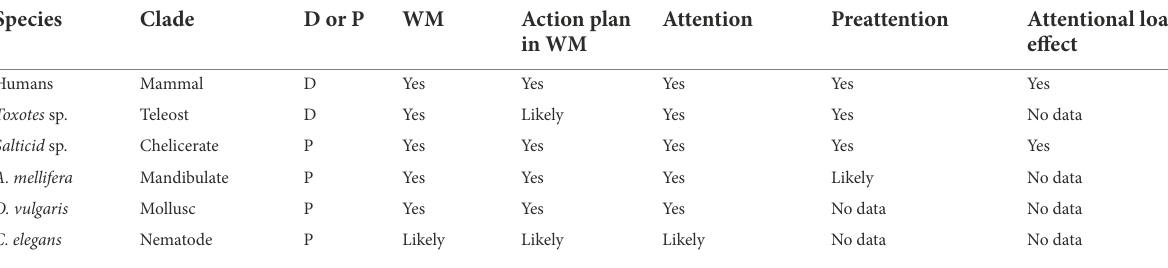
A. mellifera Mandibulate